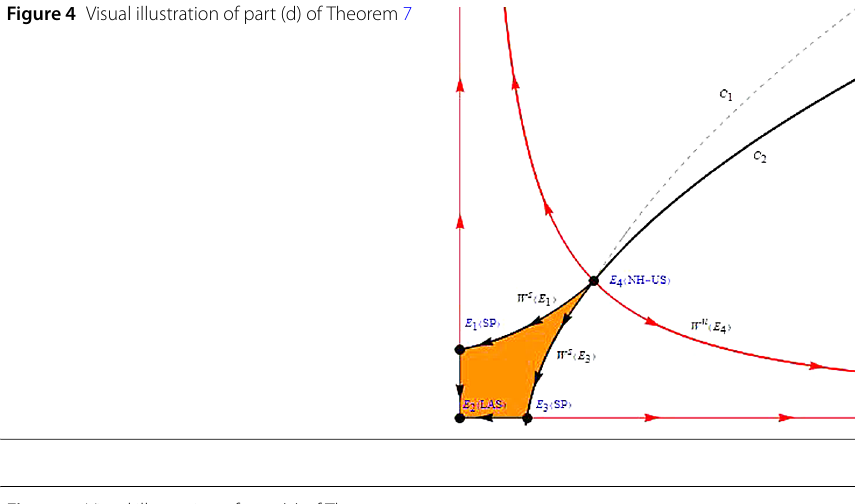
Figure 5 Visual illustration of part (e) of Theorem